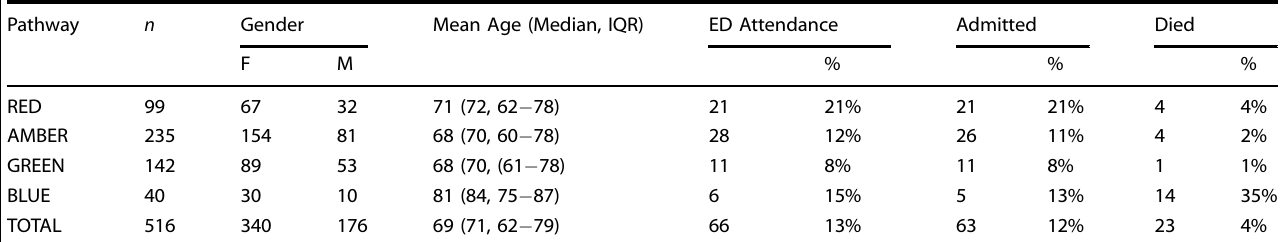
Table 2. Patient Demographics and Outcomes by CRRT Triage Pathway % relates to proportion of